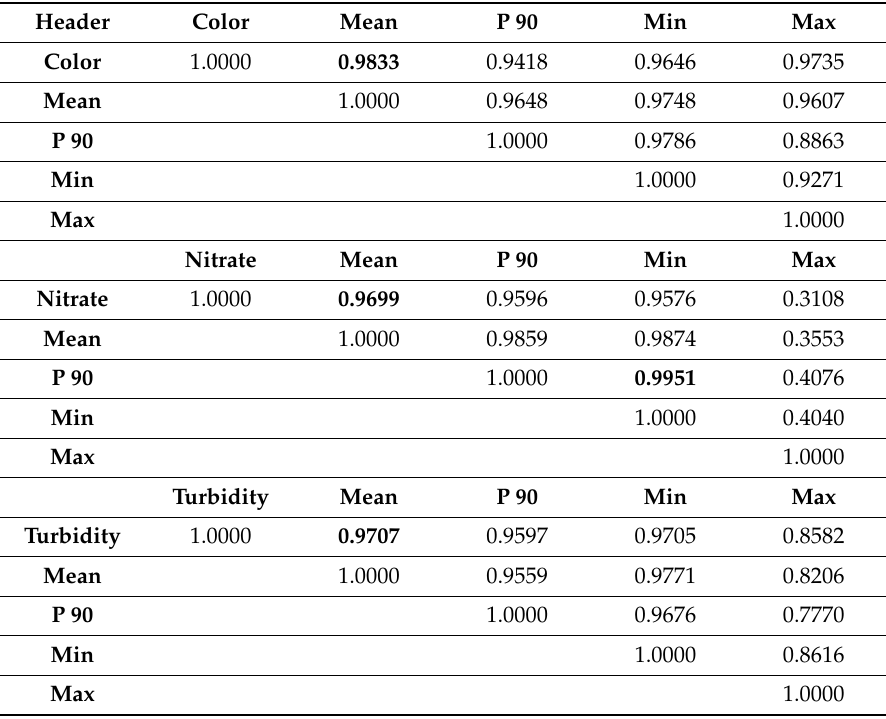
Table 2. The correlation coefficient of the water quality